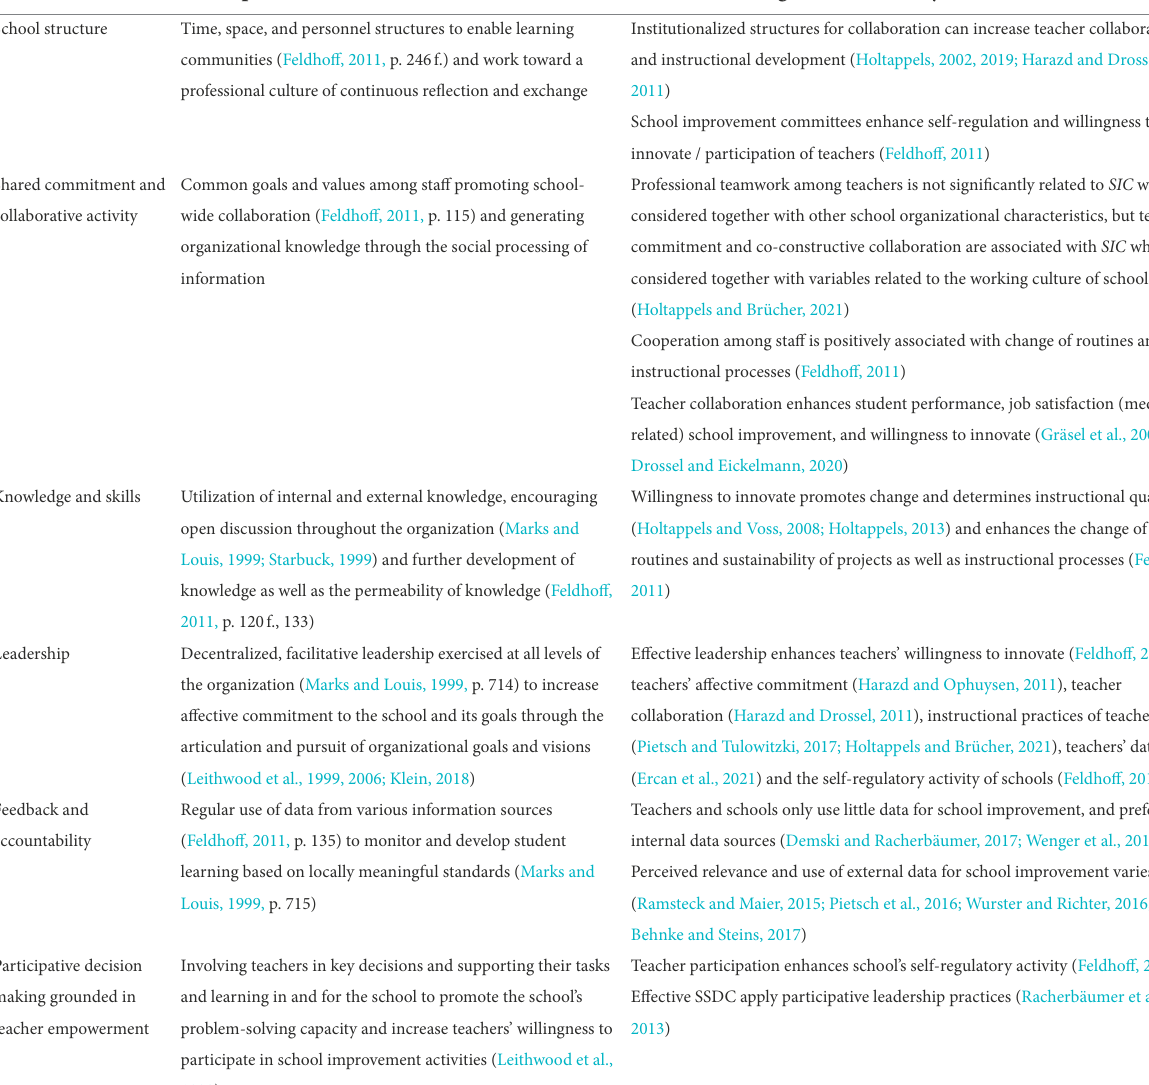
TABLE 1 Overview of the six dimensions of SIC and empirical findings from